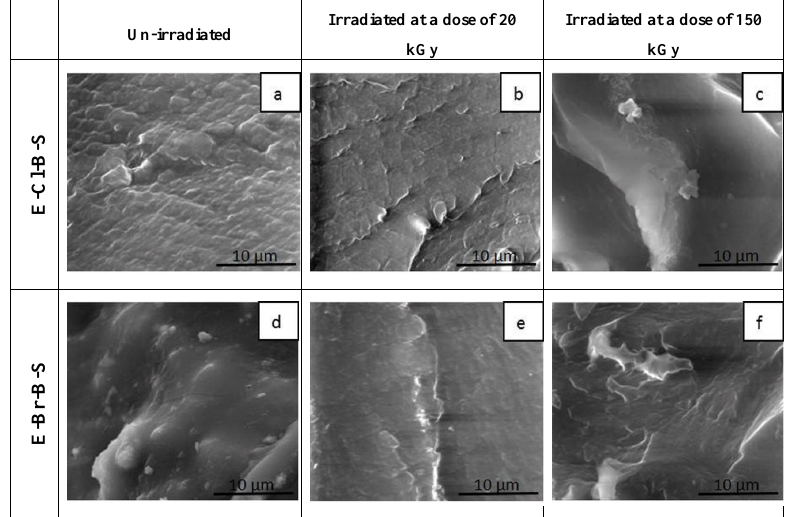
Figure 13. SEM images of fractured surfaces of EPDM/rubber/nanosilica composites before and after irradiation (10000 X magnification): ( a ) E-Cl-B-S 0 kGy, ( b ) E-Cl-B-S 20 kGy, ( c ) E-Cl-B-S 150 kGy, ( d ) E-Br-B-S 0 kGy, ( e ) E-Br-B-S 20 kGy, ( f ) E-Br-B-S 150